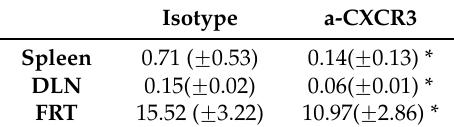
Table 3. Average frequency (± std. dev) of antigen specific CD8 + T cells detected in immunized mice.